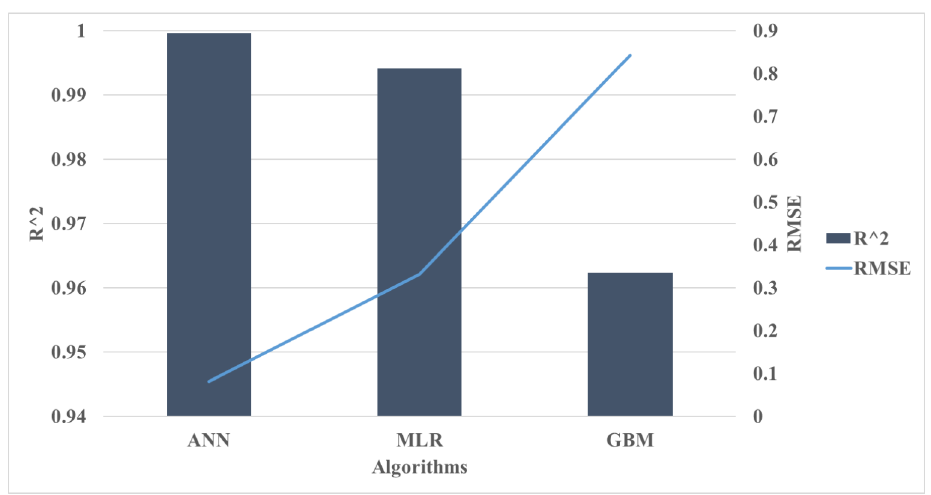
Figure 8. Data-driven models’ performance